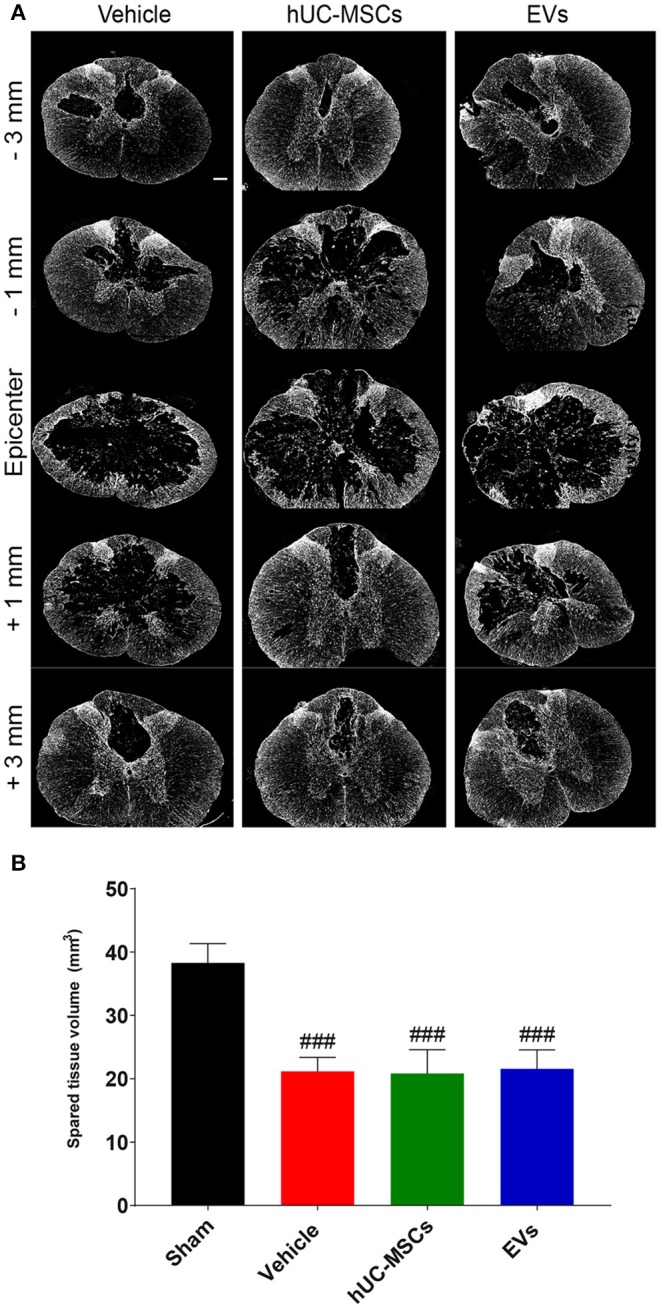
(A) Representative immunodetection of GFAP on cross-sections along the rostro–caudal axis of the spinal cord, 2 weeks after tSCI. Scale bar = 200 μm. (B) Total volume of spared spinal cord parenchyma calculated from 3 mm rostral to 3 mm caudal to the lesion epicenter or the equivalent position in the sham rats. Groups were compared using one-way ANOVA and Bonferroni post-hoc test. Statistical significances compared to sham group: ###p ≤ 0.001.